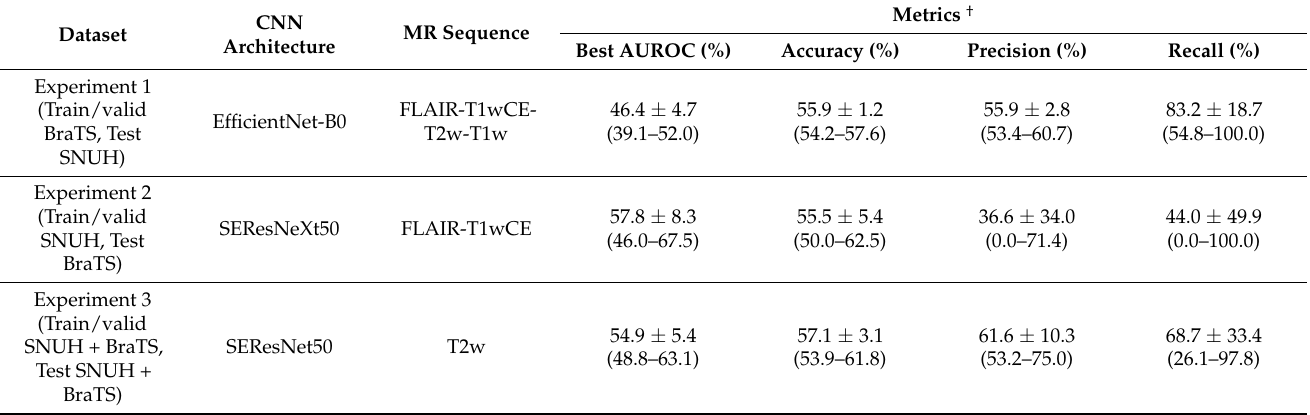
Table 3. Comparison of model performance using different models and sequences in validation sets.